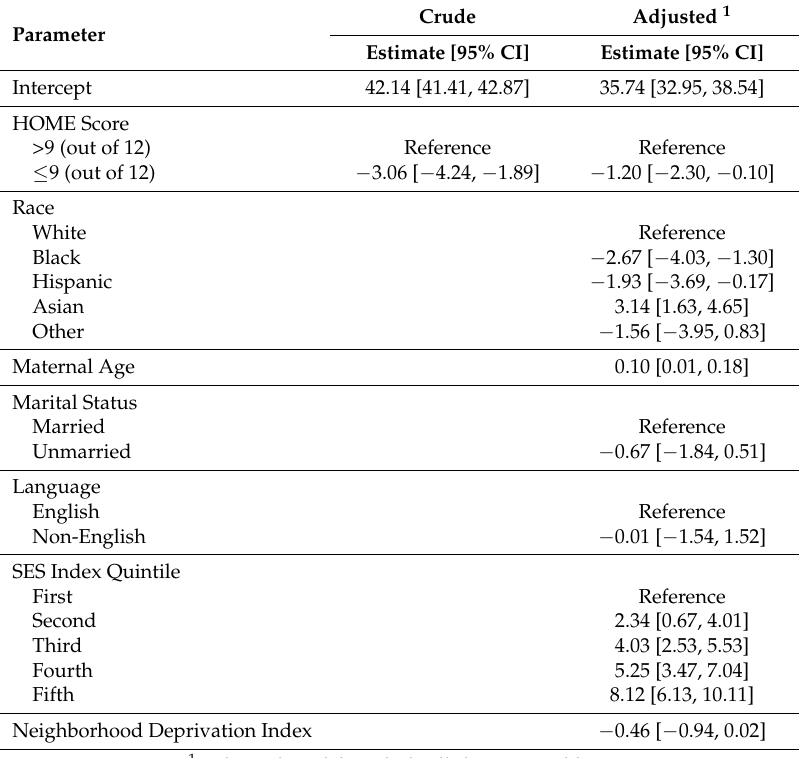
Table 3. Crude and adjusted 1 parameter estimates for associations between low HOME Score and math scale scores among the subset of the ECLS-B 2001 birth cohort living in urban communities (N = 4050).